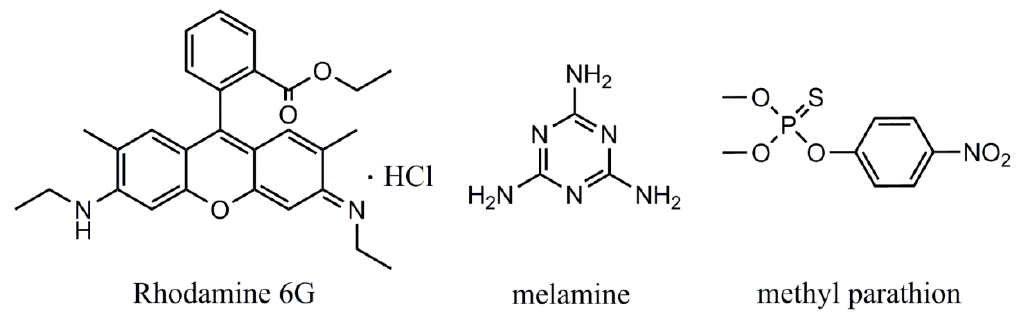
Figure 1. Chemical structures of Rhodamine 6G, melamine and methyl parathion.